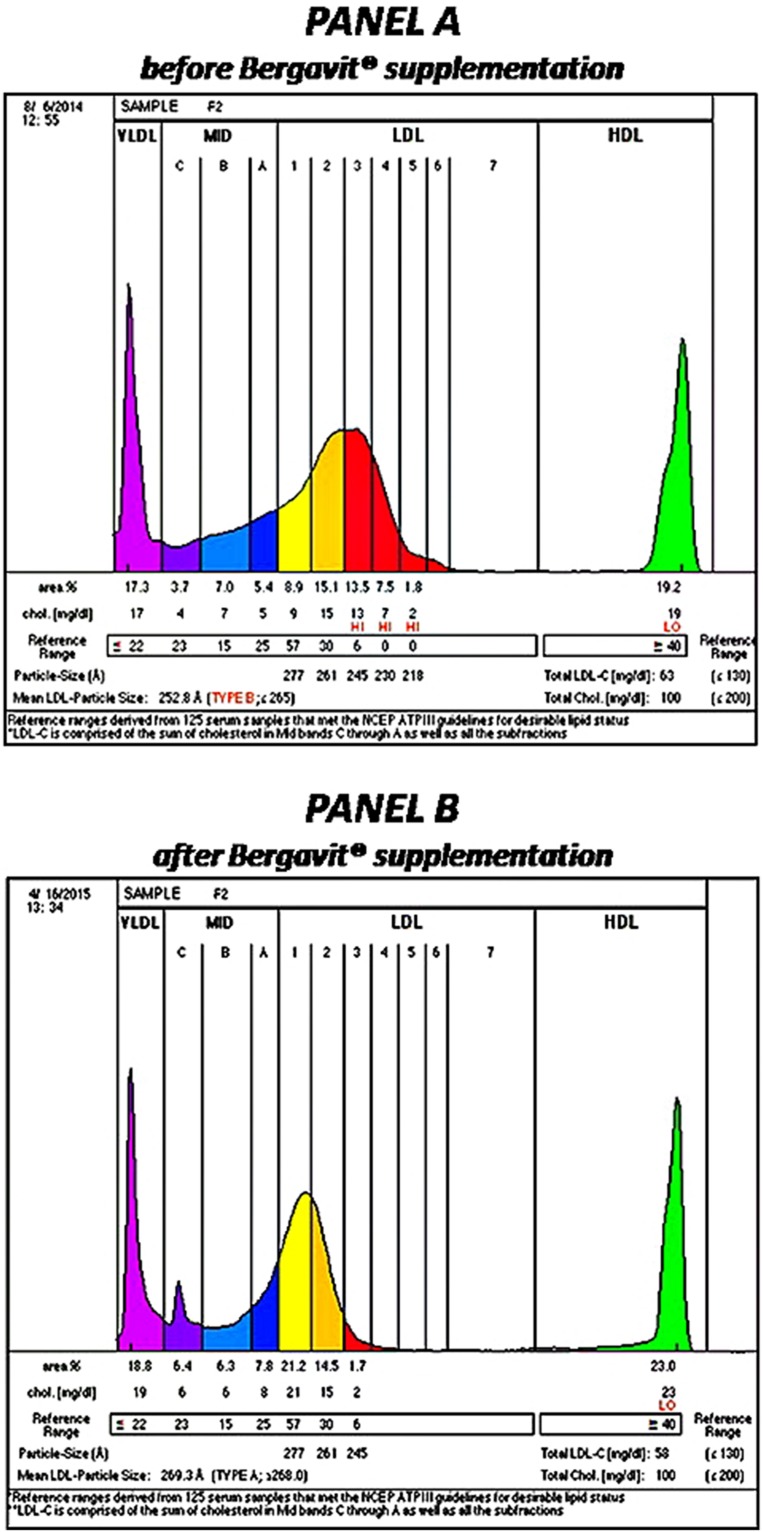
Lipoprotein profile of a rapresentative subject before (PANEL A) and after (PANEL B) 6 months of Bergavit® (150 mg of flavonoids, with 16% of neoeriocitrin, 47% of neohesperidin, and 37% of naringin, daily) supplementation. Lipoprint color graphs are generated by lipoprint sytem using Lipoware Clinical Analysis Program.